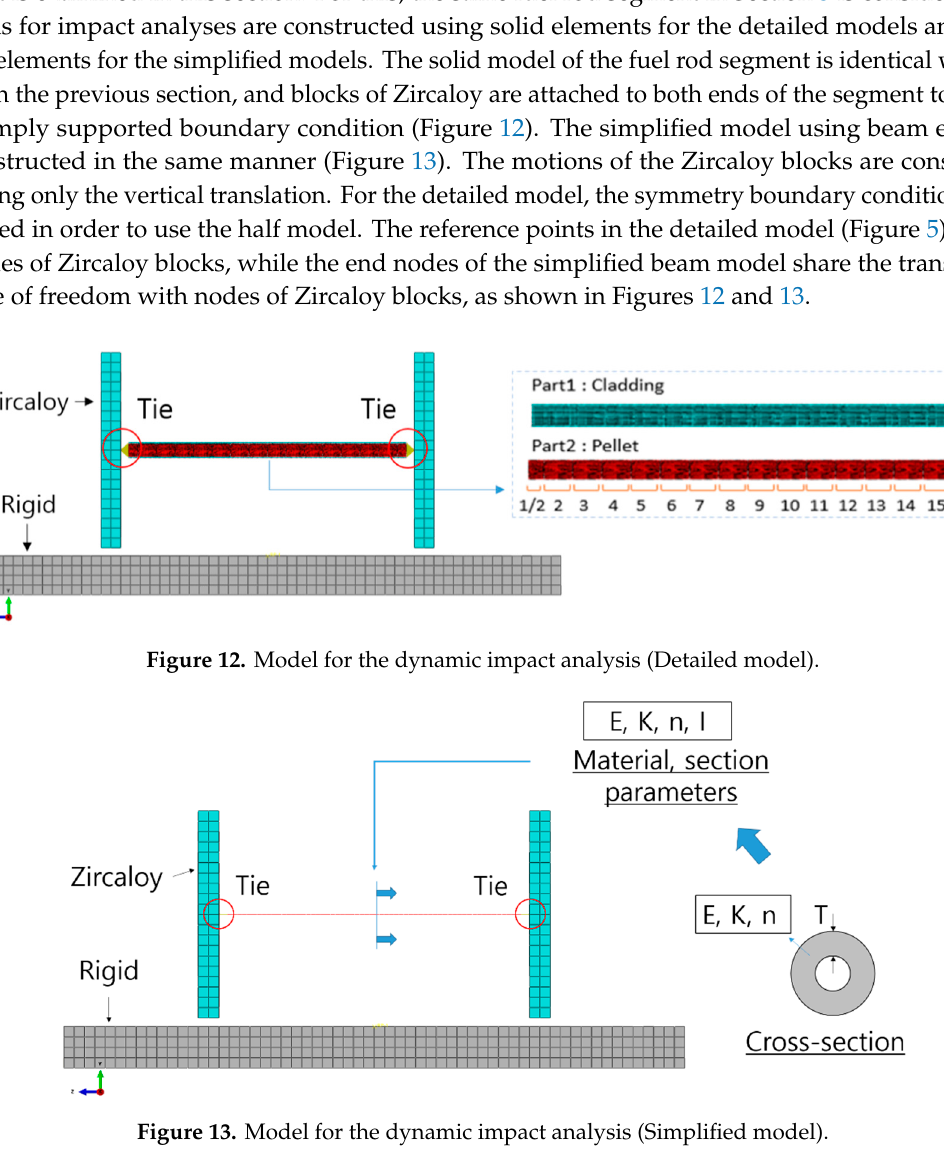
Figure 13. Model for the dynamic impact analysis (Simplified model).